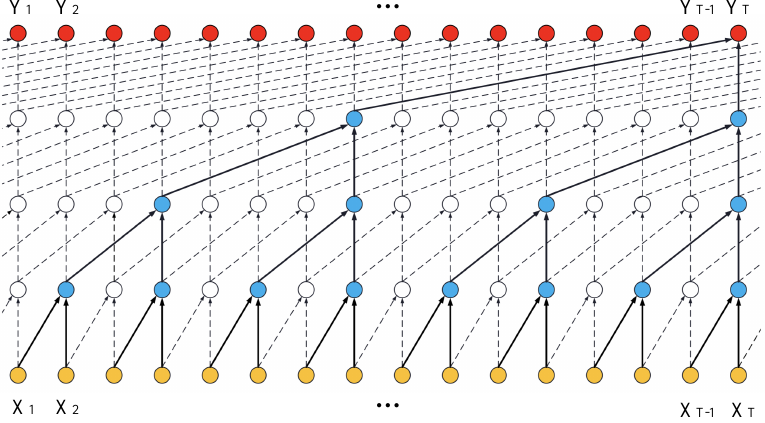
Figure 4. The basic architecture of the Temporal Convolutional Network (TCN). (1) A sequence of feature maps ( x 0 , x 1 , . . . , x T 1 , x T ) as input. (2) The feature maps are learned and decoded by − Temporal Convolutional Network. (3) The TCN architecture finally produces a sequence of learning results ( y 0 , y 1 , . . . , y T 1 , y T −